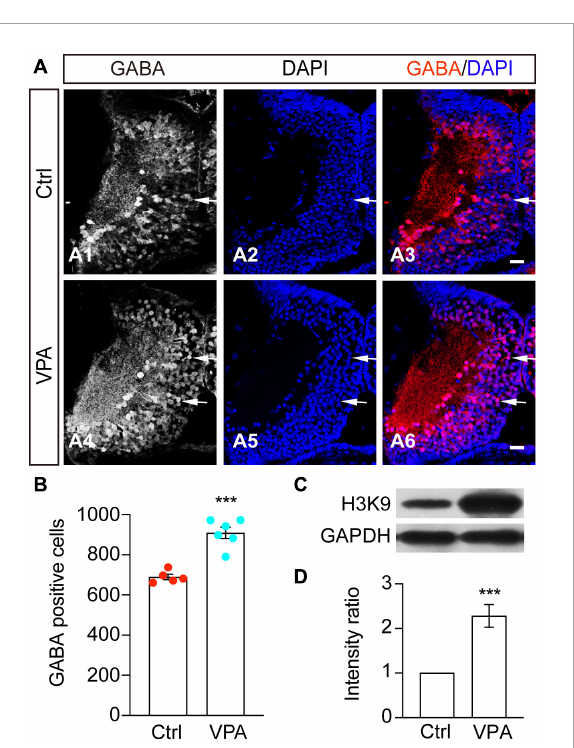
FIGURE3 The number of GABA + cells was increased by VPA treatment. (A) Representative images showing that the control (A1–3) and VPA-treated (A4–6) brains were immunostained with an anti-GABA antibody at stage 48. Arrows indicate the GABA + cells. Scale bar = 50 µ m. (B) The data shows that the GABA + cells were significantly increased by VPA treatment. GABA: Ctrl, 690.2 ± 13.4, N = 5; VPA, 909.7 ± 28.3, N = 6). N represents the number of tadpoles. (C,D) Western blot of H3K9ac and summary of data showing that the relative intensity of H3K9 to GAPDH was significantly increased by VPA treatment. N = 12. *** p < 0.001. N represents the number of independent